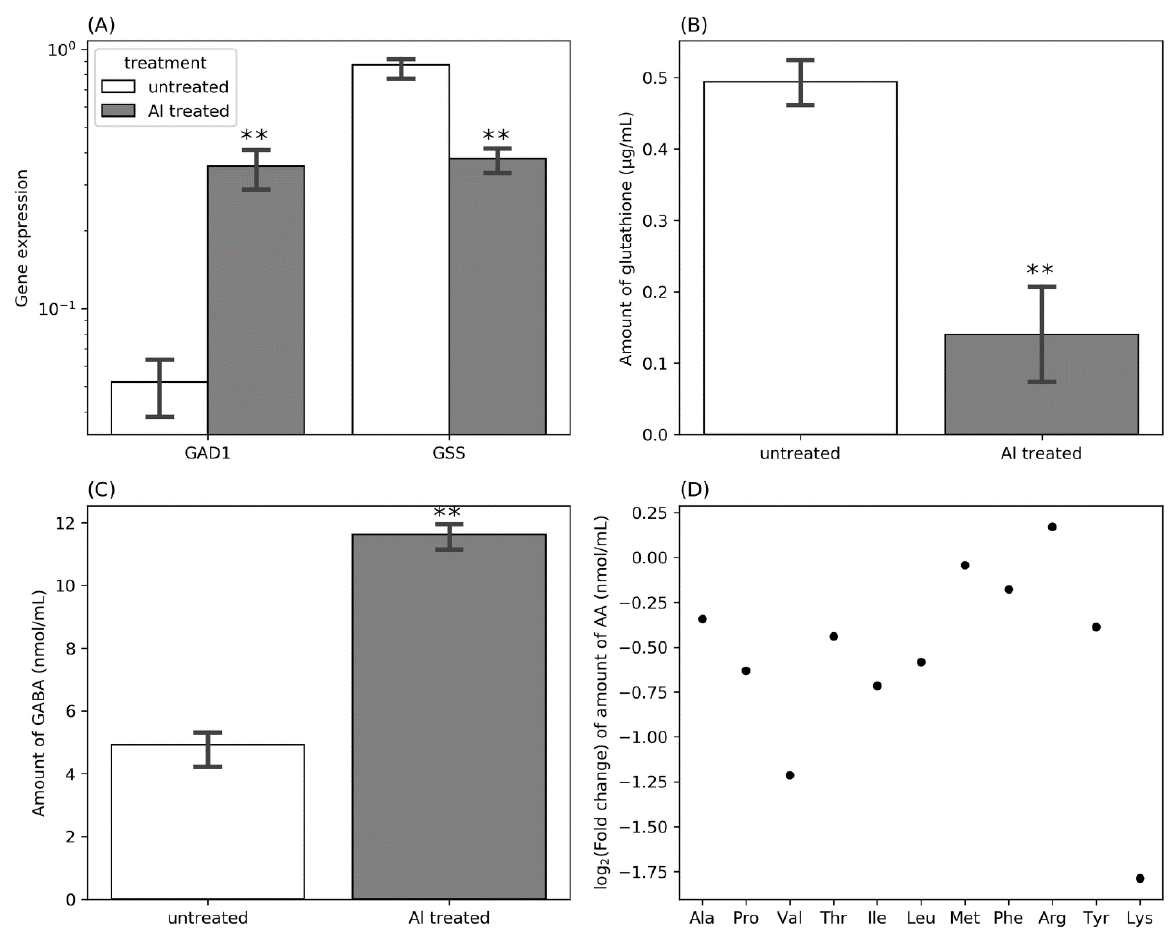
Figure 9. Expression of GAD1 and GSS genes by RT-qPCR ( A ), fold change of the amounts of GSH ( B ), γ -aminobutyric acid ( C ), and amino acids ( D ) in Al-treated cells relative to the untreated controls. Asterisks represent significant differences in the expression levels of GAD1 and GSS genes ( A ), amount of GSH ( B ), and GABA ( C ) between Al-treated samples and untreated controls (one-way ANOVA; ** p ≤ 0.001).